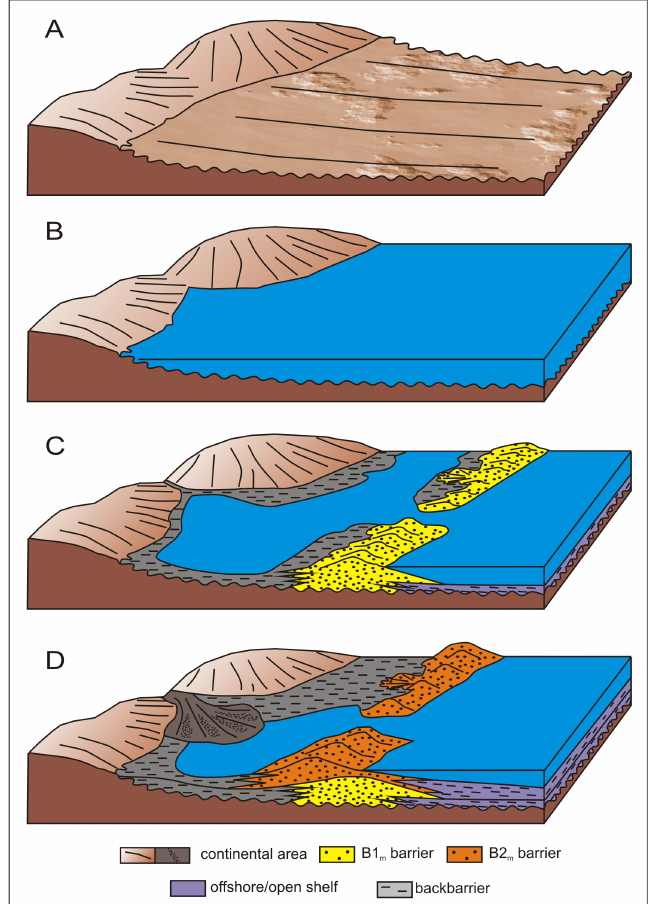
Figure 15. Evolution of unit B m , with subunit B2 m (orange) arranged in a continuous landward backstepping pattern with respect to subunit B1 m (yellow). ( A ): emergence of the ES1; ( B ): drowning of the ES1; ( C ): slowstand and formation of the first subunit B1 m ; ( D ): slowstand and formation of the second subunit B2 m , in a continuous landward backstepping pattern with respect B1 m